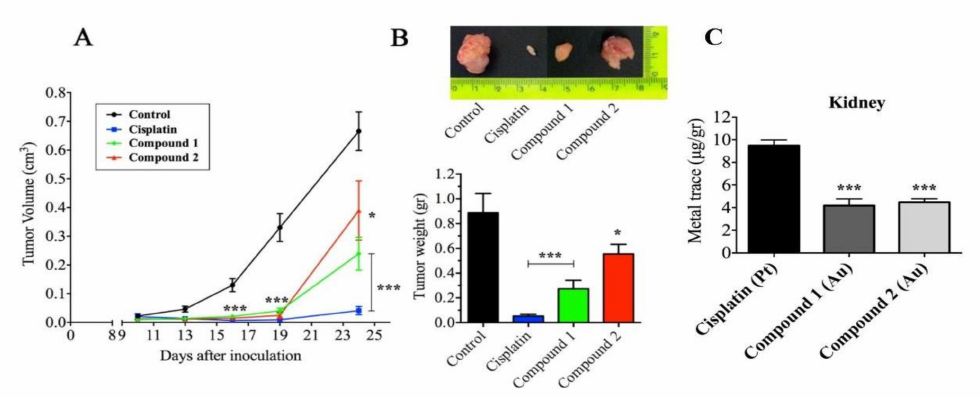
Figure 1. Compounds 1 and 2 (4,5-dichloro-imidazolate-1yl-gold(I)-triphenylphosphane and 4,5- dicyano-imidazolate-1y-gold(I)-triphenylphosphane, respectively) suppressed breast cancer growth in vivo. FVB female mice were injected with syngeneic A17 TNBC cells and treated with cisplatin, compound 1 or 2 , or isotonic solution. Treatment schedule (q3 × 4) started ten days after cell injection. ( A ) Tumor growth curves. Values are mean ± SEM, (5 mice/group). ( B ) Representative images of tumors explanted from control and treated mice at sacrifice (upper panel) and relative tumor weight (lower panel) 24 days after tumor challenge; values are mean ± SEM. The significance was determined by the one-way ANOVA test followed by Tukey’s multiple comparison post-test; each group was compared to control (* p < 0.05; *** p < 0.001). ( C ) Gold and platinum content in kidneys of mice treated with compound 1 , compound 2 , or cisplatin evaluated by inductively coupled plasma mass spectrometry (ICP-MS). The data are presented as micrograms of metal (Au or Pt) per gram of tissue. Values are mean ± SEM. The significance was determined by the one-way ANOVA test followed by Tukey’s multiple comparison test (*** p < 0.001) (modified from